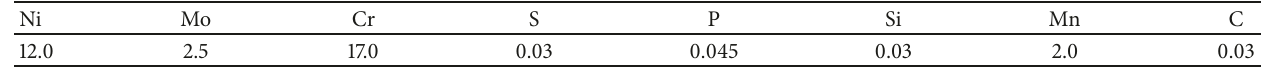
Table 1: Chemical composition for stainless steel